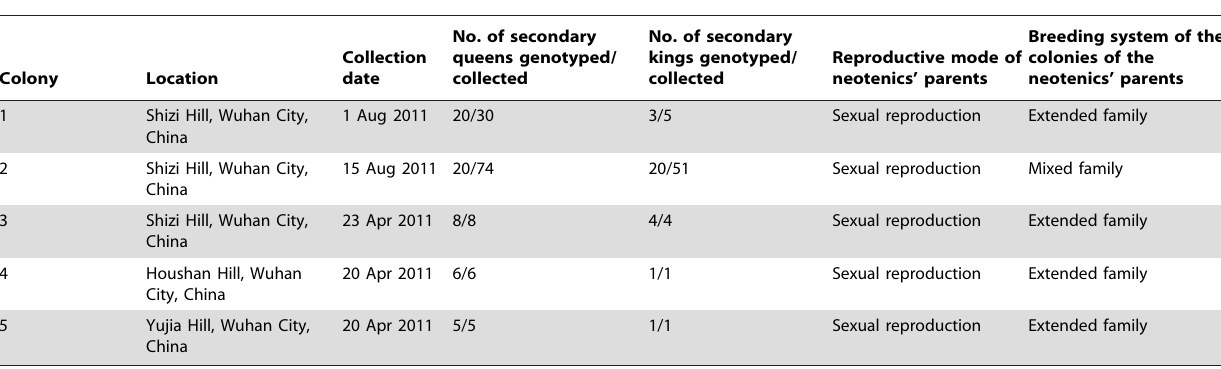
Table 3. Compositions of the five colonies headed by neotenics and reproductive mode of neotenics’ parents.